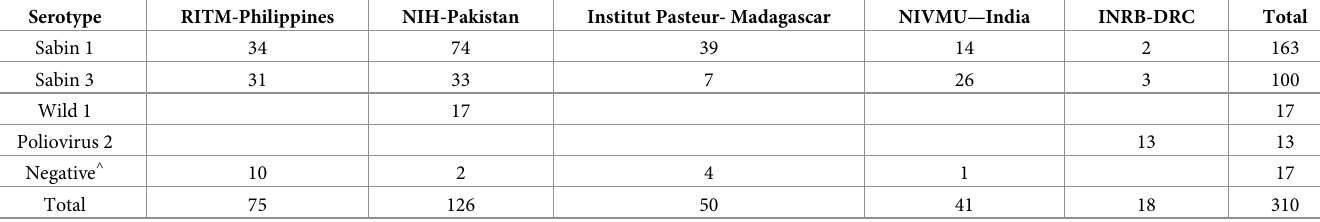
Table 4. Number of poliovirus isolates by genotype (Sabin 1, Wild Poliovirus 1 etc.) pilot tested with Zen8PV and PanPV assays by five GPLN laboratories � .